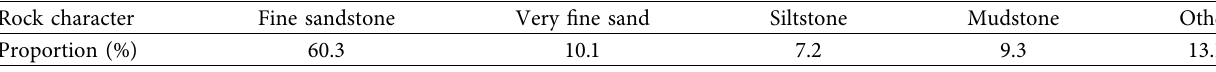
Table 2: Lithologic composition of tight oil reservoir in member 7 of Yancheng formation in Ordos.